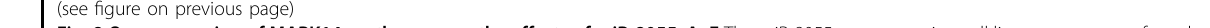
Fig. 8 Overexpression of MAPK14 partly reverses the effects of miR-8055. A – F The miR-8055-overexpression cell lines were co-transfected with MAPK14 overexpression vectors, which were compared with miR-8055-overexpression cells alone. A The overexpression ef fi ciencies of MAPK14 were detected by qRT-PCR. B Overexpression of MAPK14 abolished the suppressive effects of miR-8055 on HCM cell proliferation. C , D miR-8055 overexpression-induced downregulation of IL-1 β , IL-6, TNF- α , cTnT, CKMB, and BNP were rescued by co-transfection with MAPK14 overexpression vectors and miR-8055 overexpression vectors. E , F miR-8055 overexpression-induced decrease of cell apoptosis was reversed by co-transfection with MAPK14 overexpression vectors and miR-8055 overexpression vectors. Data are presented as mean ± SD (n = 3 biologically independent samples). * p < 0.05; ** p < 0.01; *** p < 0.001 (Student ’ s t test). G Graphical abstract. Graphical diagram of circACSL1 promoting myocardial in fl ammation and myocardial injury by sponging miR-8055 and regulating MAPK14